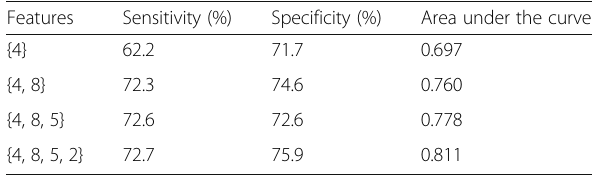
Table 2 Performance of different feature combinations using the decision tree method Features